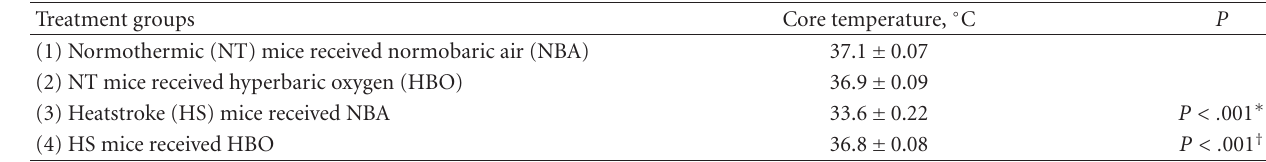
Table 2: Mean ( ± SE) of core temperature values for di ff erent groups of mice ( n = 8 per group). Treatment